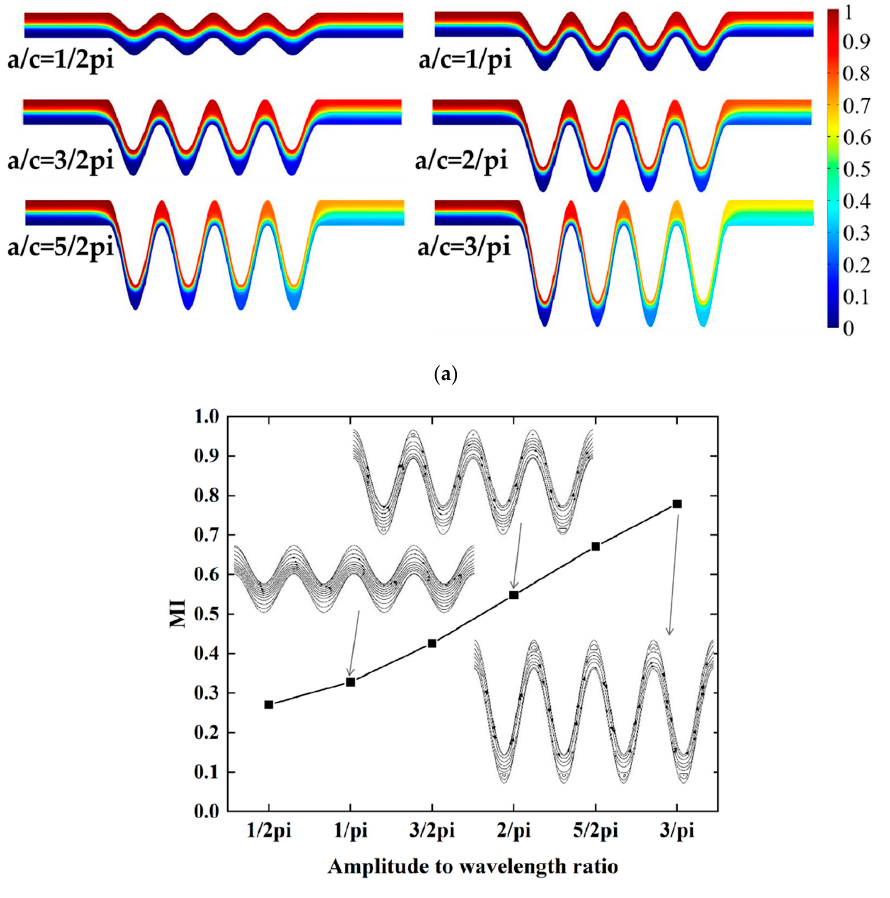
Figure 4. The effect of the amplitude-to-wavelength ratio: ( a ) distributions of concentration surface along the micromixer for the different amplitude-to-wavelength ratios (a/c), ( b ) the mixing index at the outlet for different values of amplitude-to-wavelength ratios (a/c).